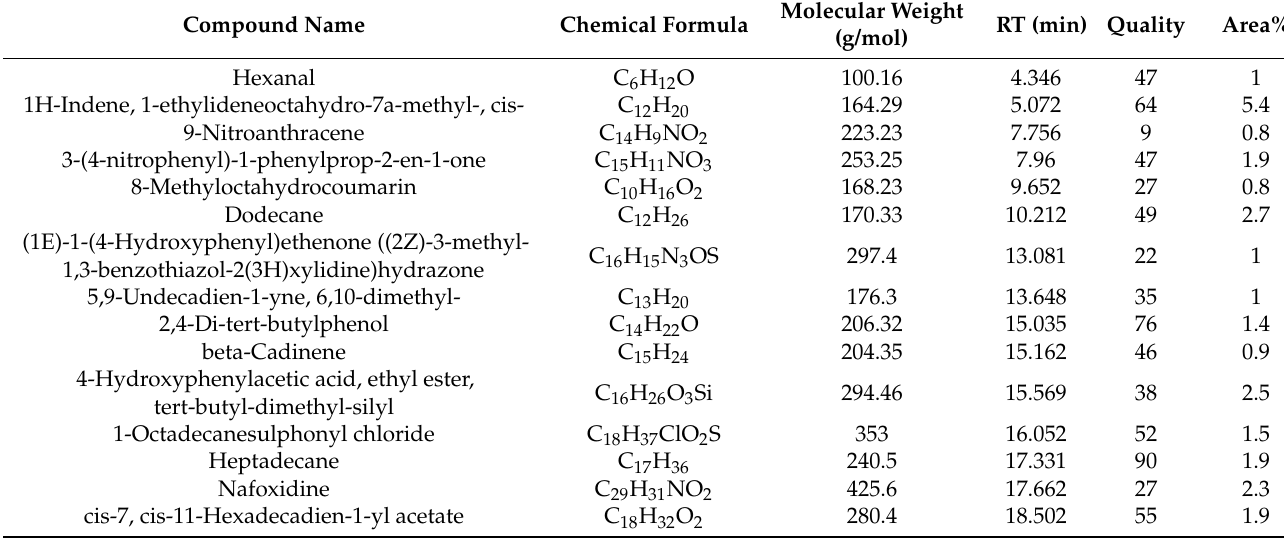
Figure 3. Mycelium and biomass produced on potato dextrose broth at 25 °C for two weeks using a shaking incubator at 200 rpm. ( A ) single ascospore of T. nivea (Spore diameter is equivalent to 16.5 μm), ( B ) type of mycelia produced on the growth medium, and ( C ) wet biomass. Table 1. The GC-MS analysis of the crude ethyl acetate obtained from wet mycelial biomass produced using ascospores of T . nivea